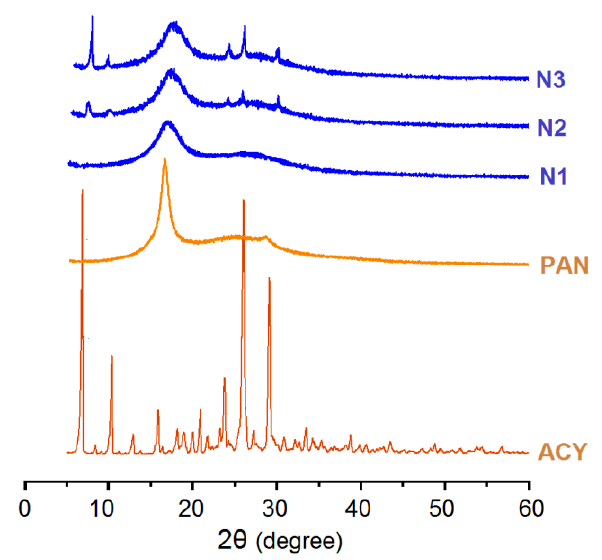
Figure 6. The XRD patterns of the drug, ACY; polymer, PAN; their composites of N1; and their nanohybrids of N2 and N3.